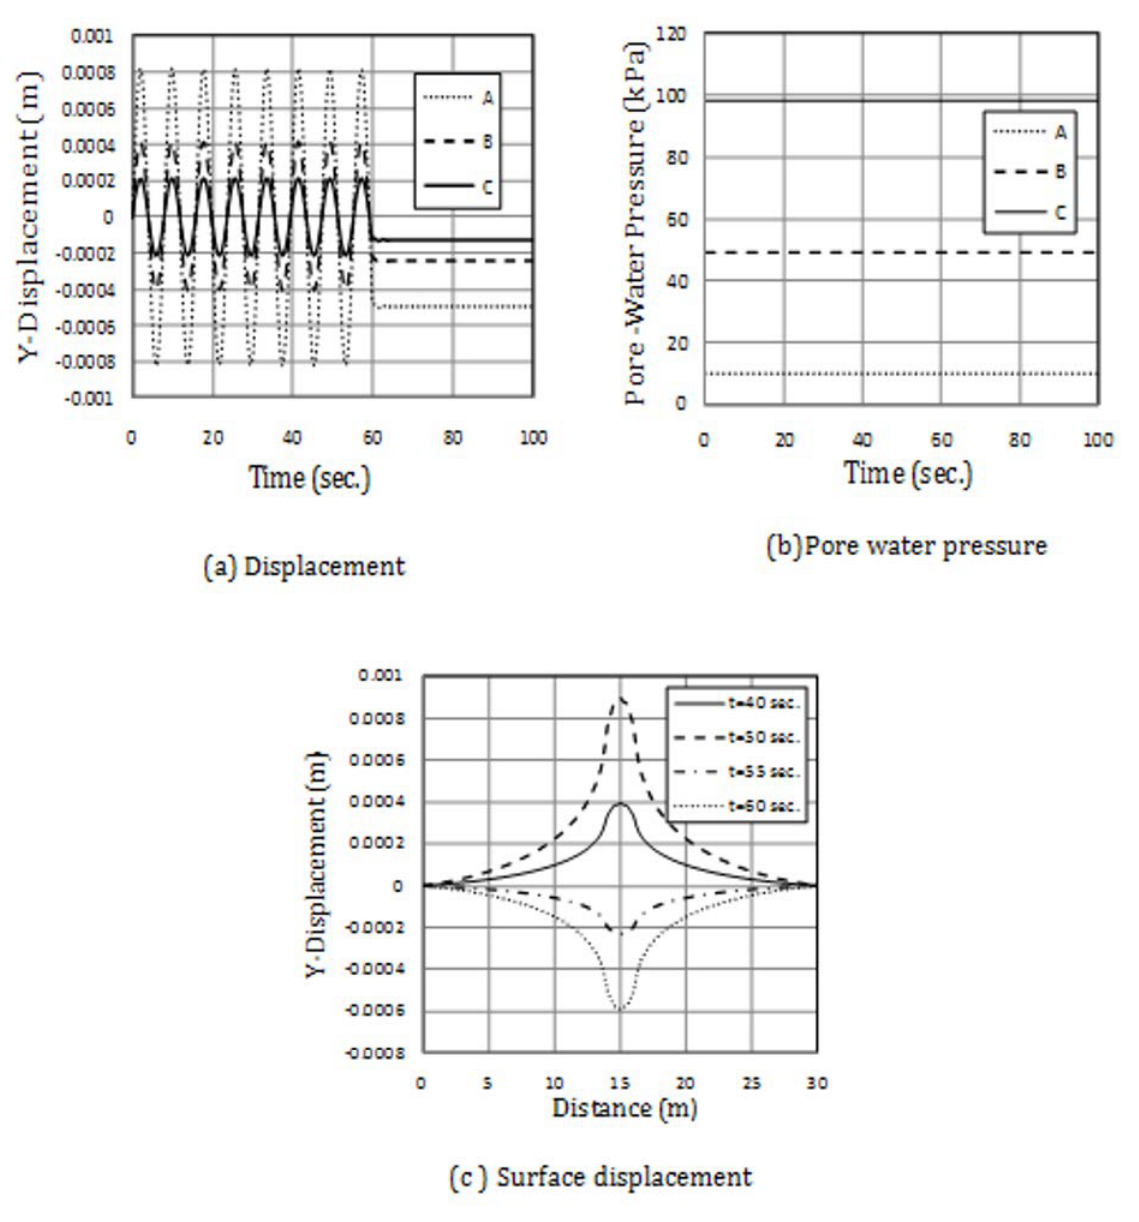
Figure 5. Dynamic response of the foundation to harmonic load, a